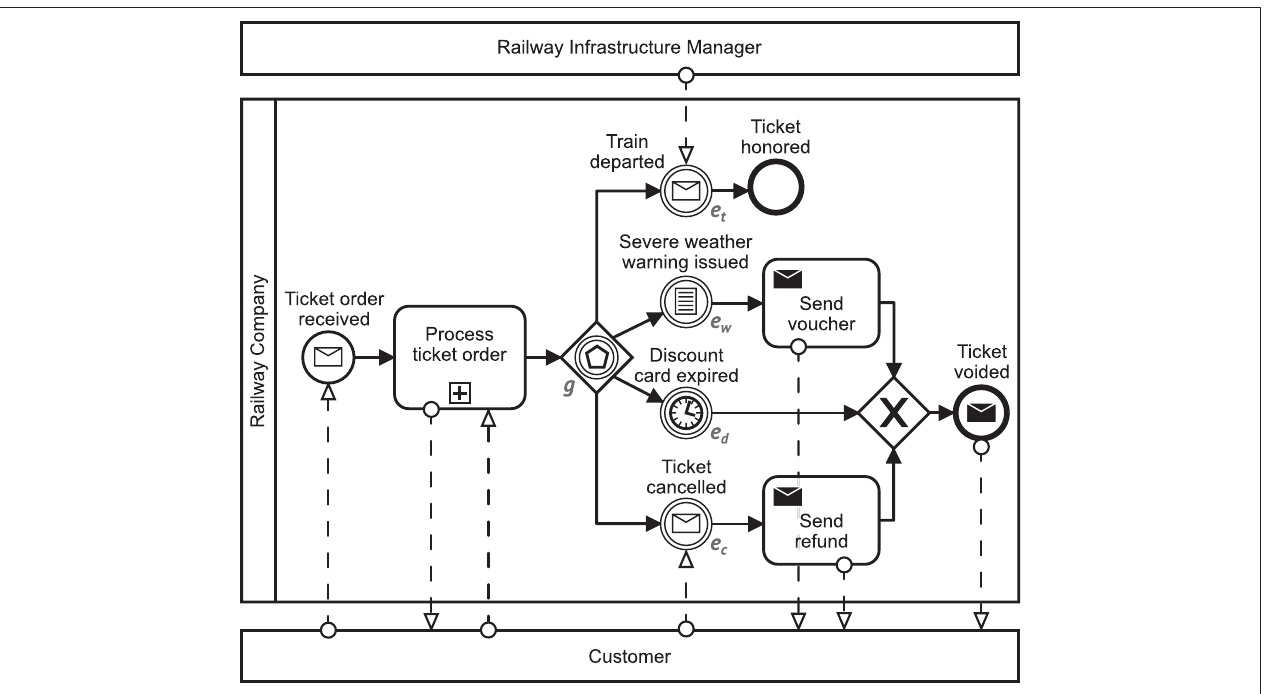
FIGURE 1 | Running example of a deferred choice scenario.